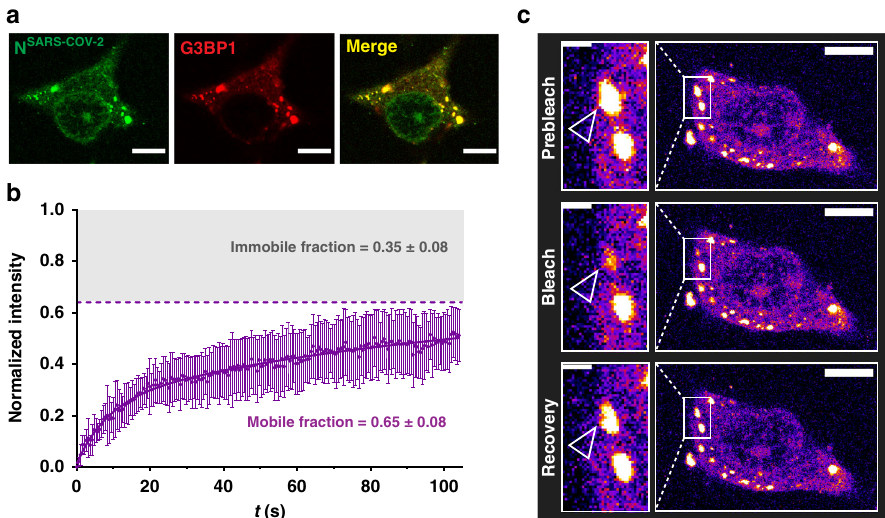
Fig. 2 Nucleocapsid protein of SARS-CoV-2 associates with stress granules. a Alexa Fluor 488 labeled N SARS-CoV-2 (green) colocalizes with the stress granule marker G3BP1 (red) in arsenite-treated digitonin-permeabilized HeLa cells. Micrographs are representative of three independent biological replicates. b Fluorescence recovery after photobleaching (FRAP) curve fi tted with bi-exponential fi t suggests the existence of a fast diffusing population of molecules, which together with a slowly recovering population comprises ~65% of the bleached spot (mobile fraction). The remaining 35% are immobile and do not recover its fl uorescence after photobleaching. The curve is the average of n = 6 stress granules, error bars represent standard deviation. c Corresponding confocal microscopy pictures of the representative FRAP of N SARS-CoV-2 associated with stress granules in HeLa cells. Insert shows the bleached stress granule marked with an arrow. Micrographs are representative of n = 6 FRAP experiments in one biological sample. Scale bar 10 µ m in ( a ) and ( c ), 2 µ m in the inset in ( c